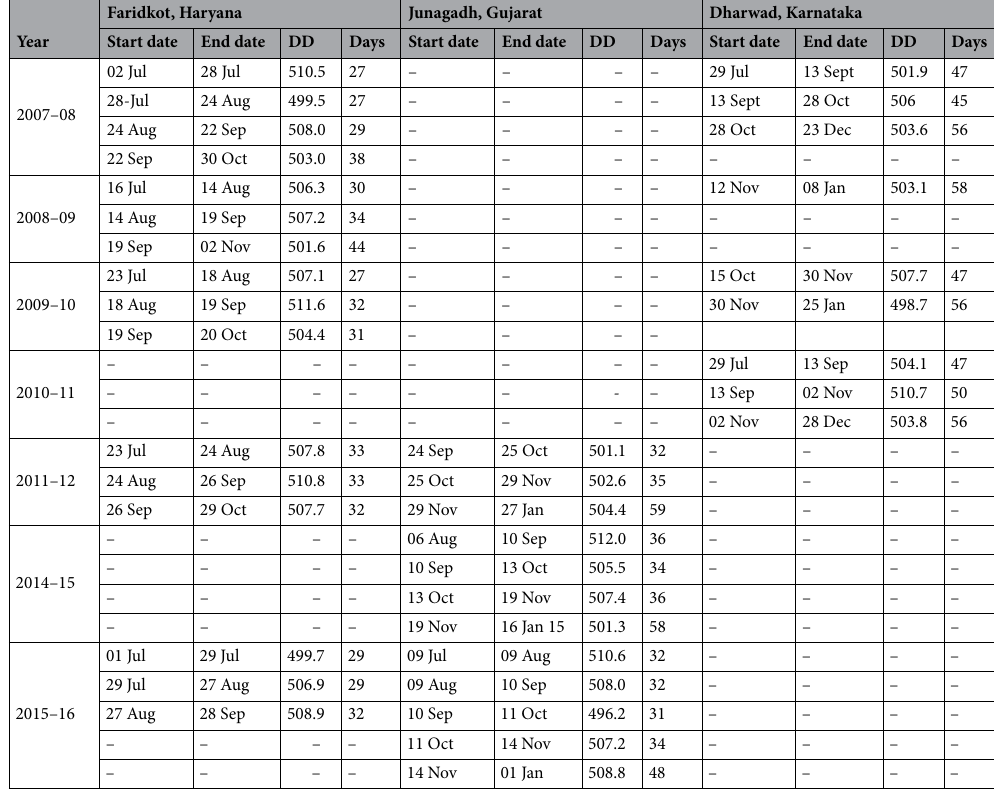
Table 2. Validation of degree-day model of cotton pink bollworm in three different cotton growing zones of India. The degree days were accumulated between successive moth catch peaks starting from beginning of moth emergence for each year at each